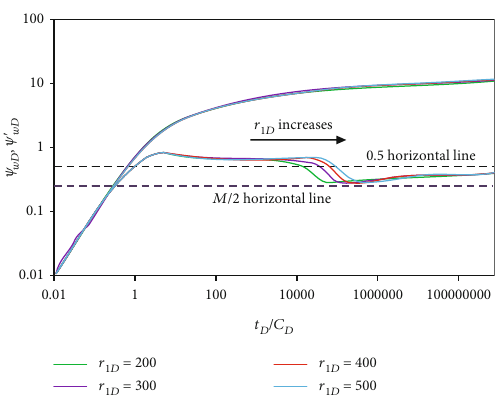
Figure 14: Well test curves of the pressure drawdown well test under di ff erent inner zone radii.